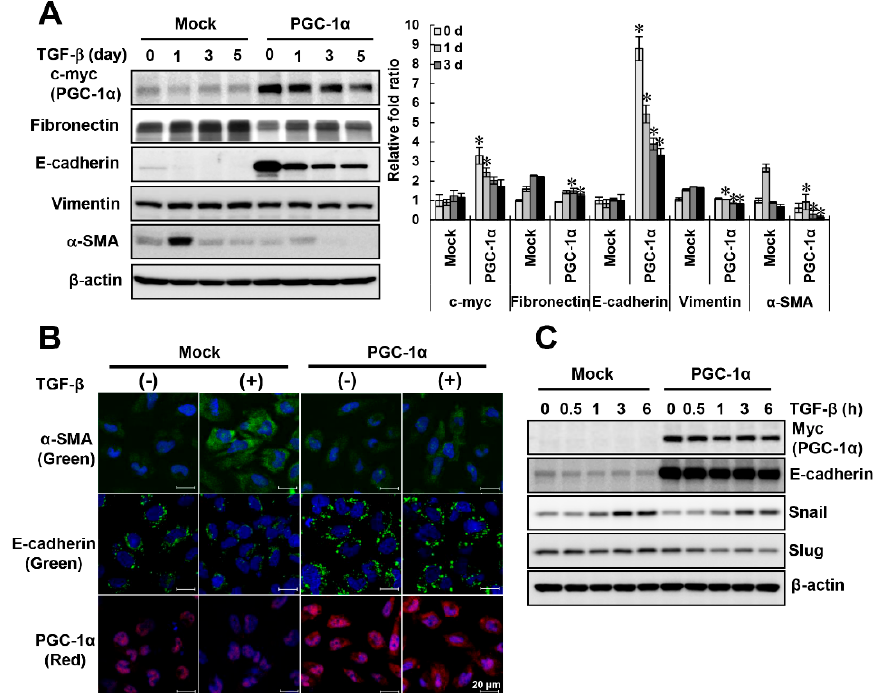
Figure 3. Comparison of EMT phenotype in TGF- β -treated mock or PGC-1 α HK-2 cells. To confirm the protective effect of PGC-1 α on EMT, HK-2 cells stably overexpressing PGC-1 α (PGC-1 α cells) and mock cells were treated with TGF- β and compared. ( A ) The protein expression levels of PGC-1 α (c-myc tagged) and EMT markers (fibronectin, E-cadherin, vimentin, and α -SMA). ( B ) Morphological changes in PGC-1 α (red) and EMT markers (green, labeled E-cadherin and α -SMA) by immunofluorescence staining (original magnification, 800×; bar = 20 μ m). ( C ) Effects of changes in transcription factors (Snail and Slug) on E-cadherin expression in both cell lines were compared. Bar graphs show mean PGC-1 α (c-myc-tagged), fibronectin, E-cadherin, vimentin, and α -SMA/ β -actin expression levels, as measured by densitometry. * p < 0.05, mock cells vs. PGC-1 α cells at the indicated time (0, 1, 3, and 5 days).